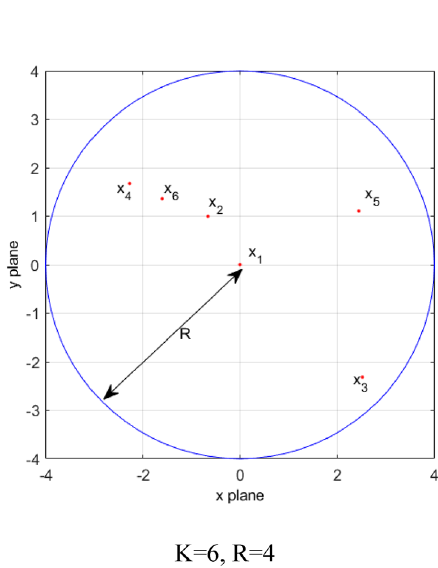
Figure 10. Distribution of the cooperative